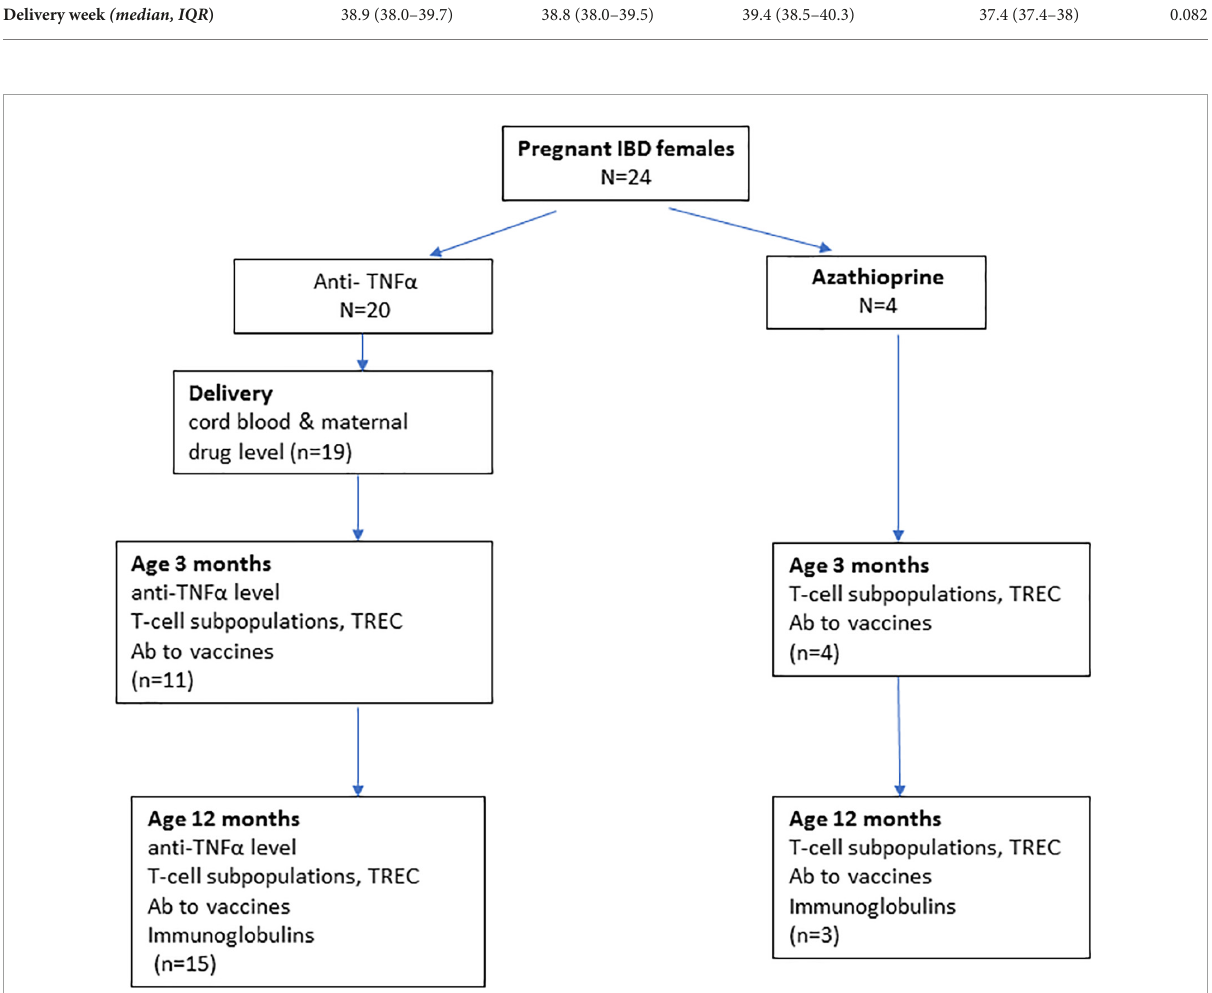
FIGURE1 Immune function tests performed at each age of the study